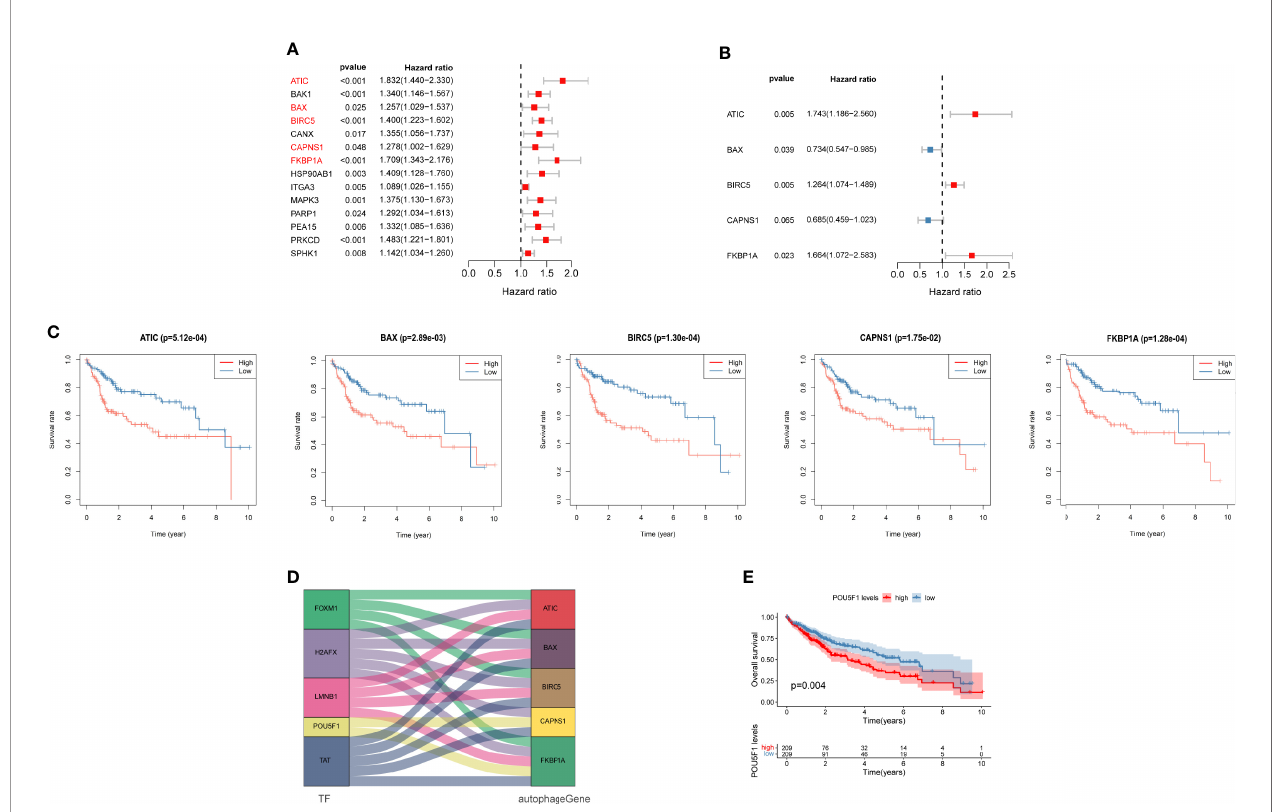
FIGURE 6 | Autophagy-related prognostic genes for patients with liver cancer. (A) Univariate and (B) multivariate Cox regression analyses revealed the pool of prognosis-related genes. (C) Analysis of the Kaplan – Meier survival curve for TCGA cohort. (D) Mulberry map of transcription factors and autophagy-related genes (ARGs). (E) Analysis of the Kaplan – Meier survival curve for